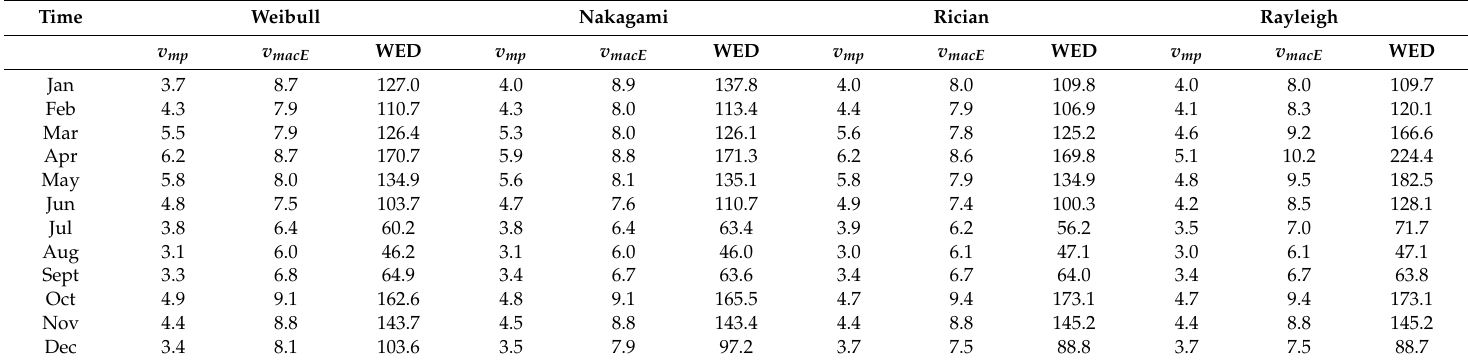
Table 12. Monthly wind potential